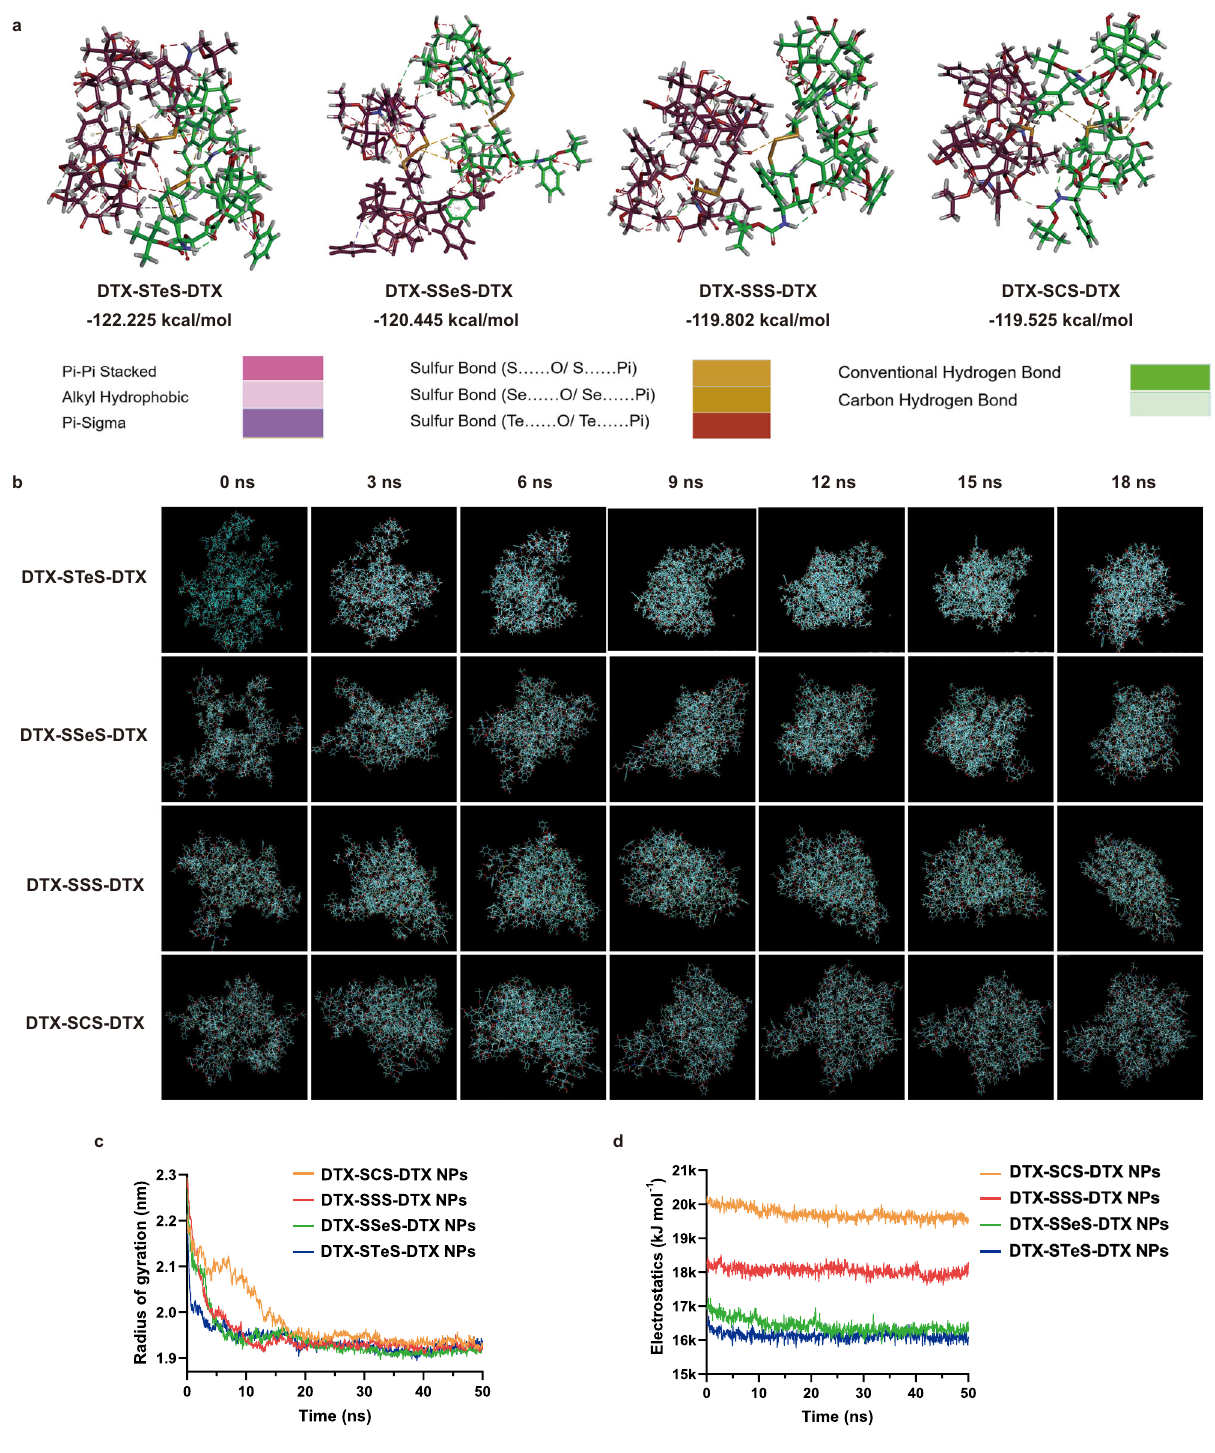
Fig. 3 | Self-assembly mechanism of HPNAs. a Intermolecular forces and free energy changes of HPNAs. b Schematic diagram of the aggregation process of HPNAs from 0ns to 18ns. c Changes of the radius of gyration during aggregation.